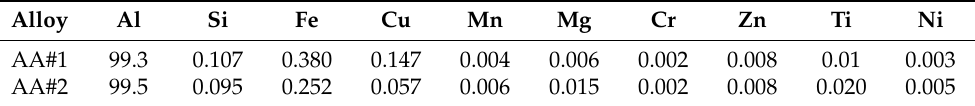
Table 1. The weight elemental composition of investigated aluminum alloys. Alloy